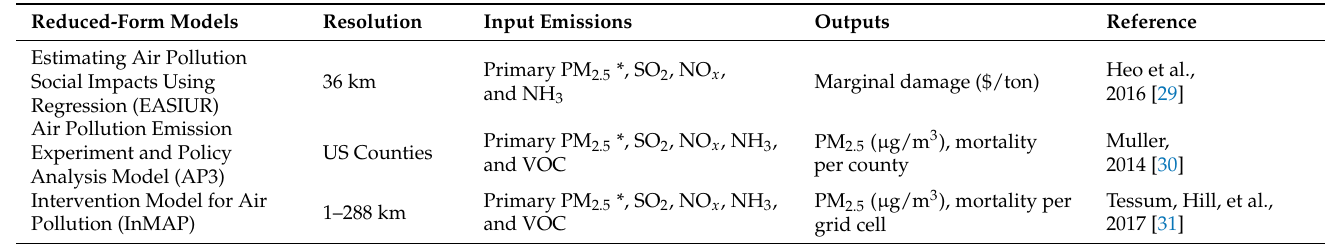
Table 2. Intercomparison of three reduced-form models, including resolution, input emissions, and